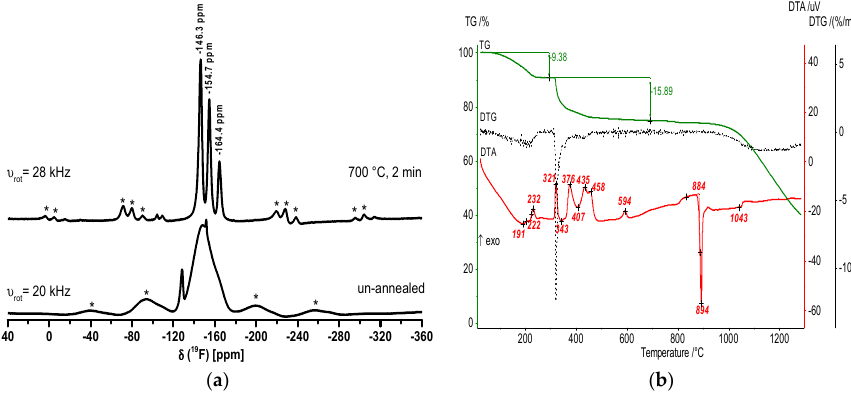
Figure 4. 19 F MAS NMR spectra of un-annealed and annealed CaAlF 5 xerogel at 700 ° C for two minutes ( a ) and TG/DTA heating curves ( b ). The spinning sidebands in the MAS NMR spectrum are located under the * symbols.